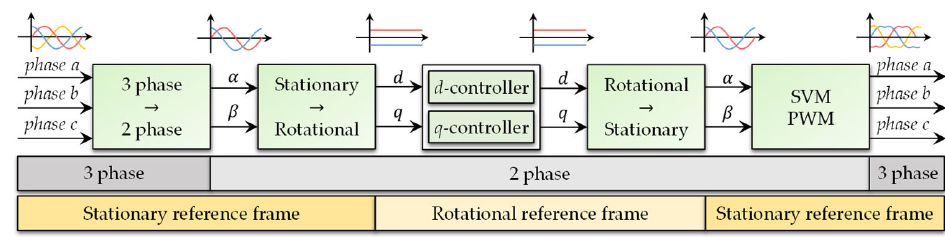
Figure 4. Transformations in FOC